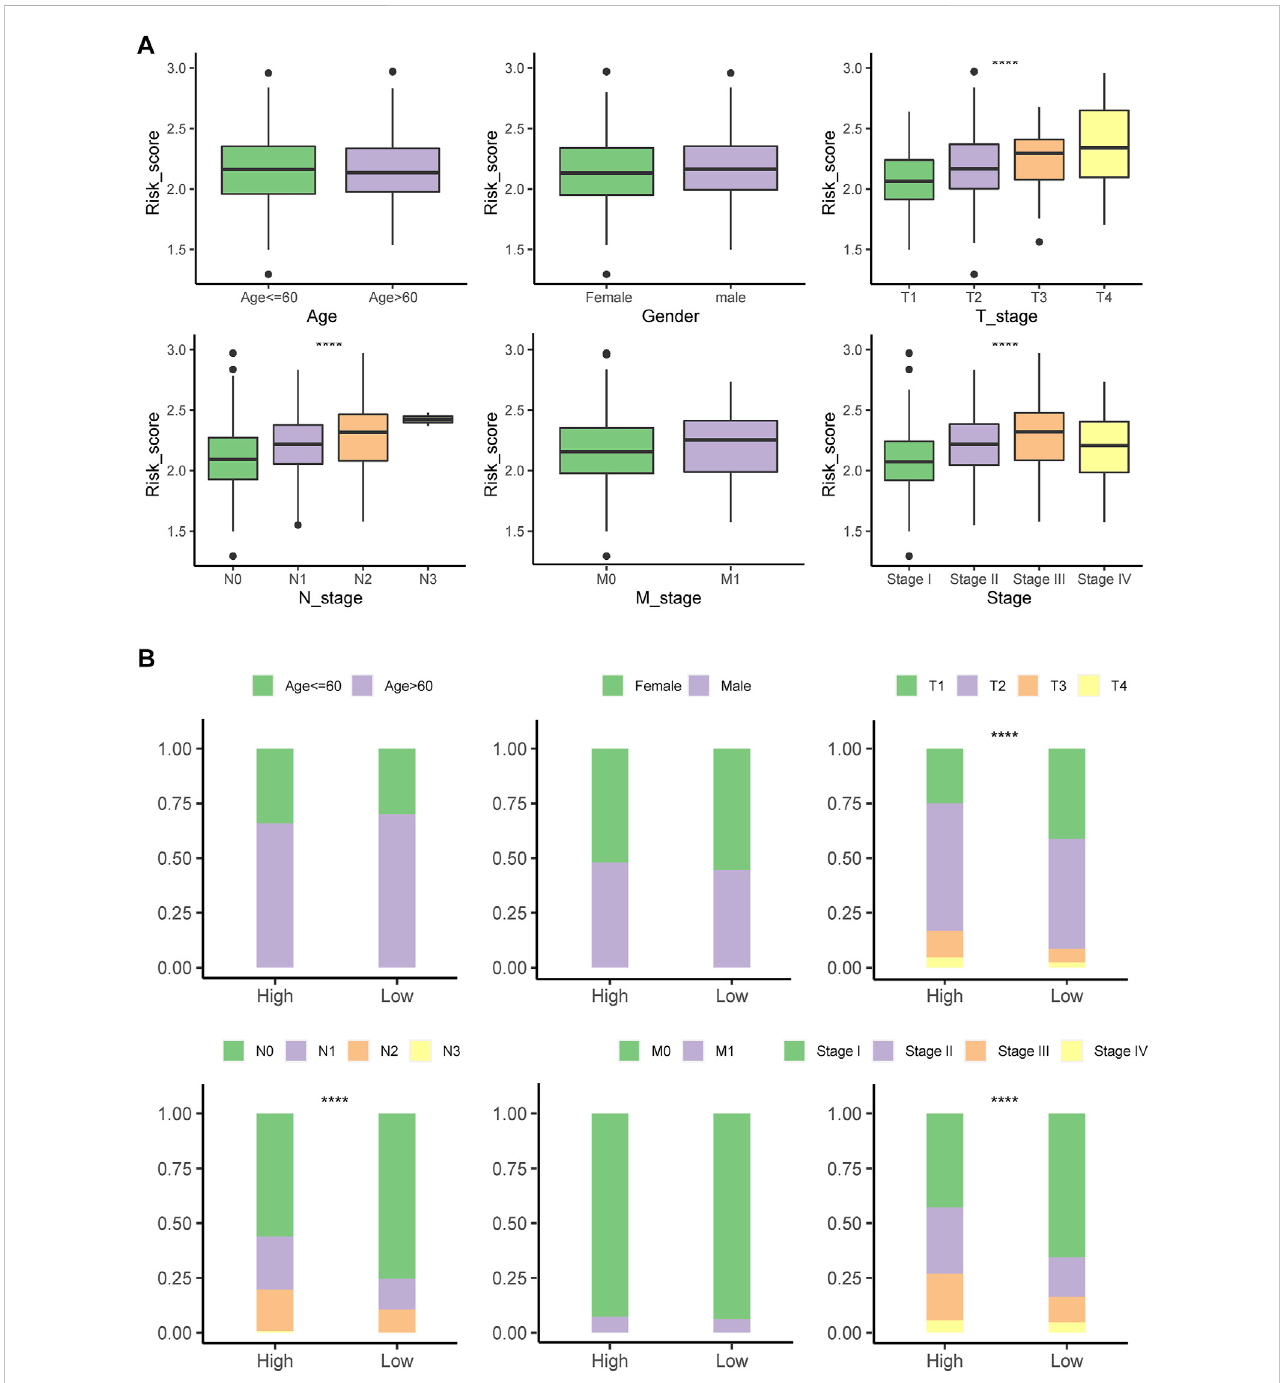
statistically signi fi